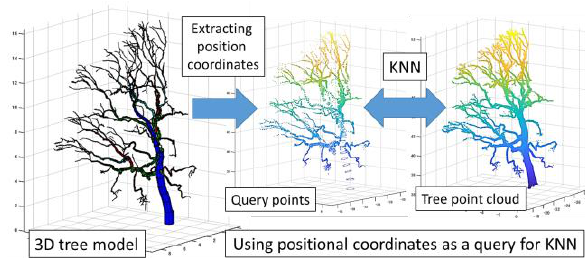
Figure 10. Method of accuracy verification